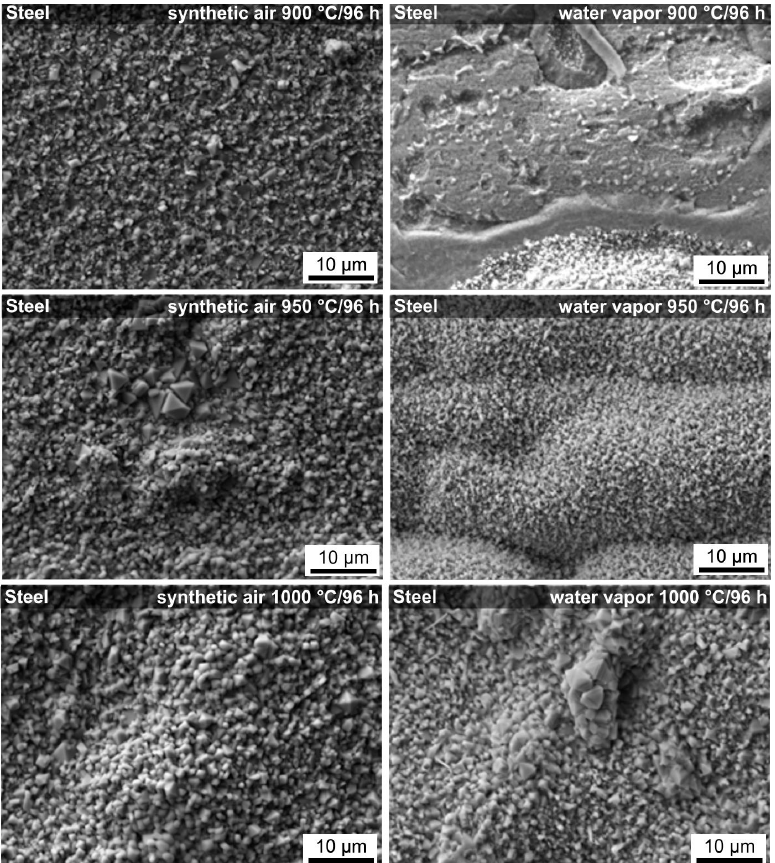
Figure 6. SEM micrographs of uncoated steel surfaces after oxidation tests in synthetic air and water vapor.